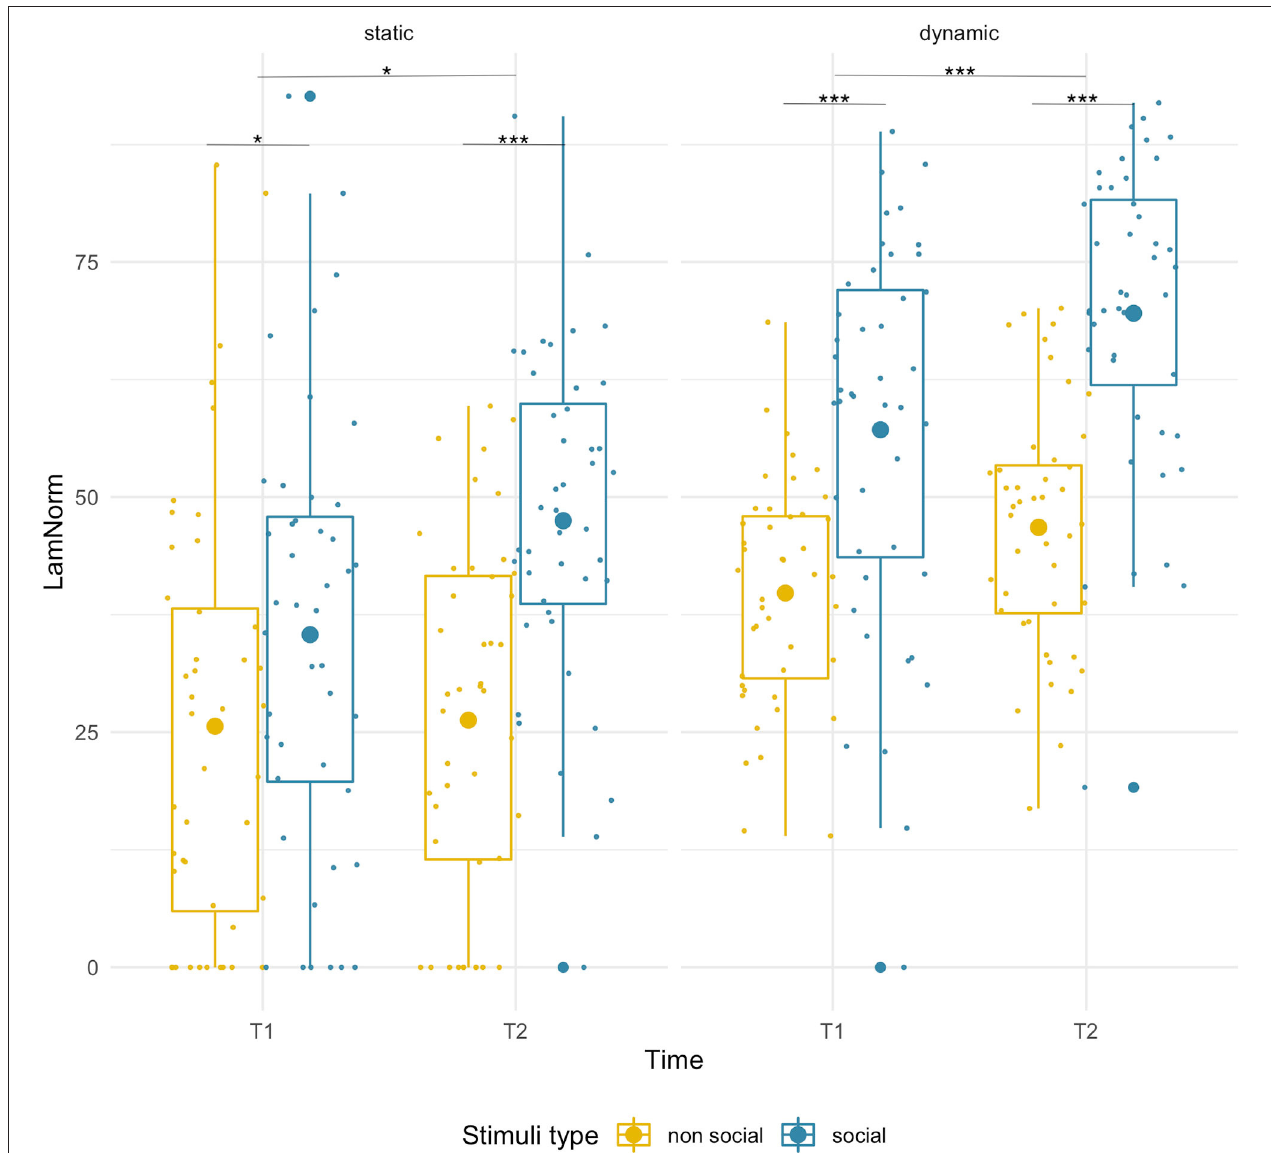
FIGURE 4 | Box plots with individual data showing distribution of normalized laminarity for each stimulus type. The big dot inside each box indicates the mean value. Significant differences marked with asterisks: * p < 0.05; ** p < 0.01; *** p < 0.001.